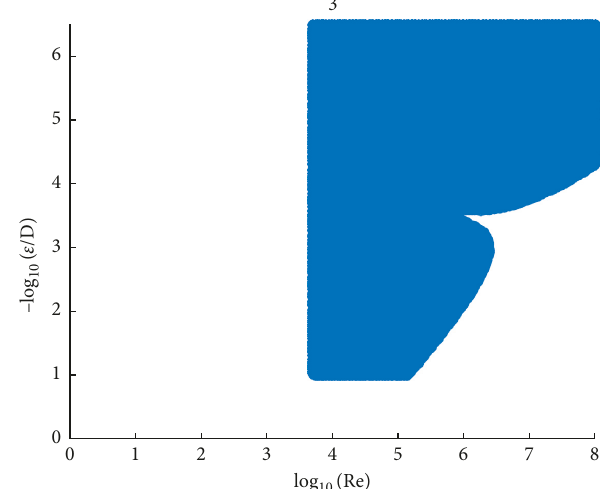
Figure 5: Decreased maximal number of required iterations from 4 8 for solving Colebrook’s equation in to 3 to reach accuracy of 10 Halley’s and Schr¨oder’s procedure when calculation goes through − the transmission factor x where the initial starting point is with the fixed value: x 0 (cid:31)